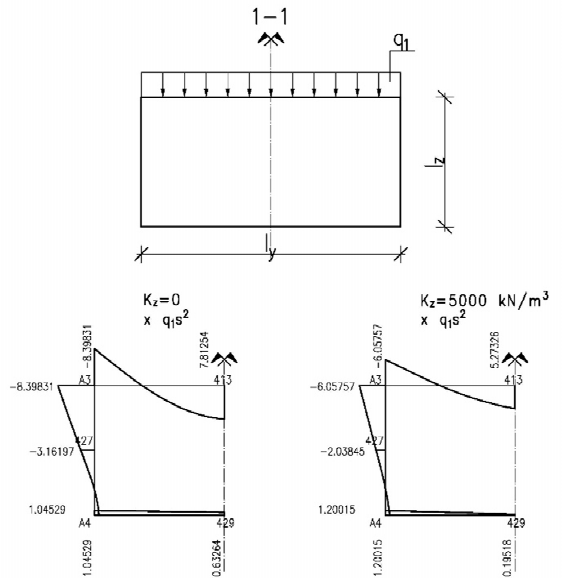
Figure 7. Charts of bending moments due to the uniform load of the top plate without taking into account the effect of an elastic substrate and for the Poisson’s ratio ν = 0 and taking into account the effect of an elastic substrate K = 5000 kN/m 3 and for the Poisson’s ratio ν = 0 in cross section 1–1 (Figure 4).